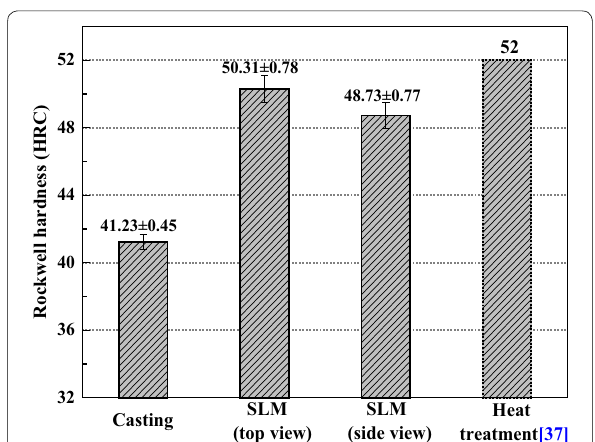
Figure 6 Hardness obtained for casting and SLM‑produced